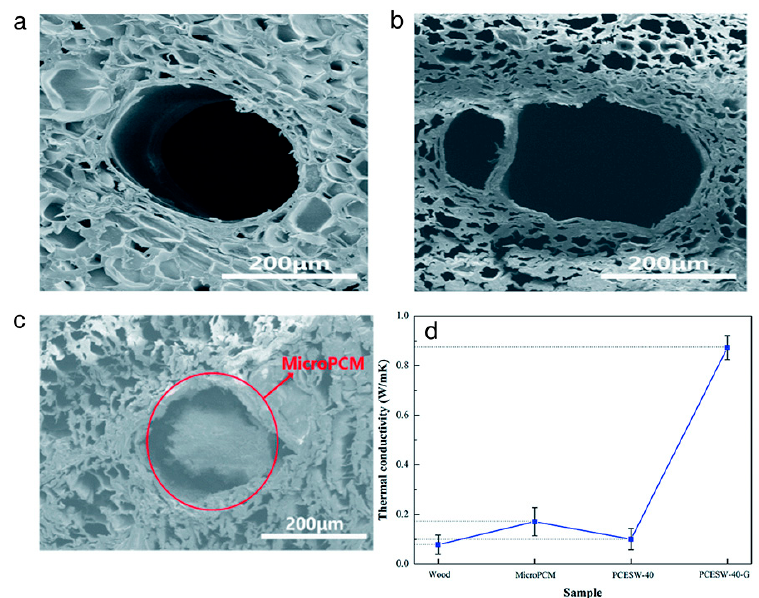
Figure 2. ( a ) Scanning electron microscopic (SEM) images of balsa wood before delignification; ( b ) SEM image of delignified wood; ( c ) microstructure image of phase change energy storage wood and ( d ) thermal conductivity curves of phase change energy storage wood. Adopted from reference [36], copyright 2020, Royal Chemical Society.